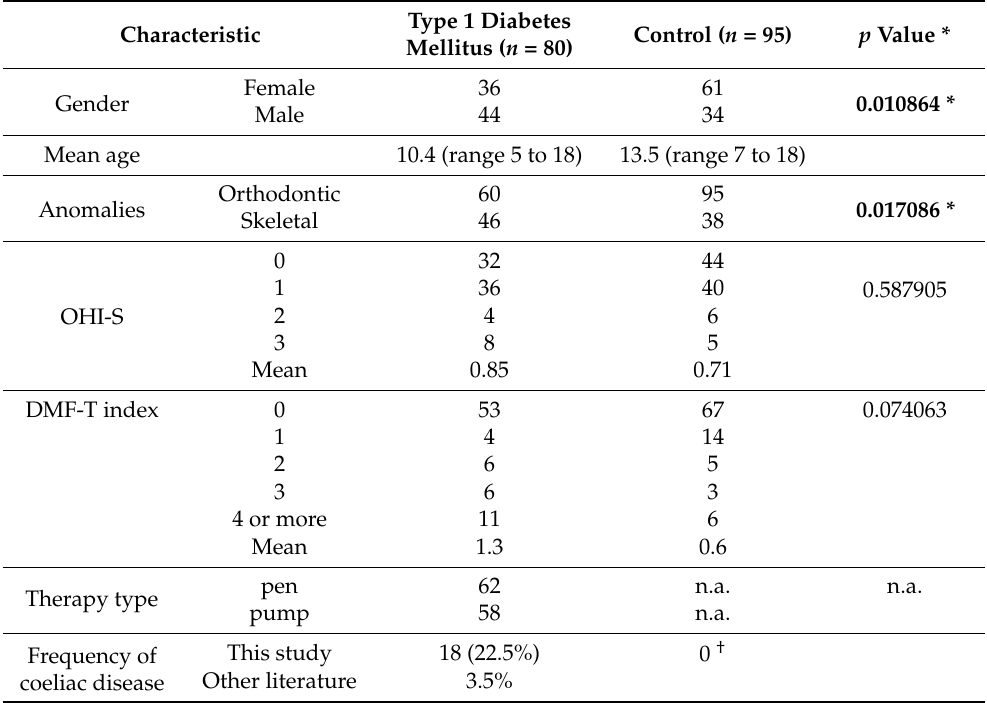
Table 3. Screening evaluation data were obtained from the Department of Paediatric Dentistry and Orthodontics diabetes ambulance and control